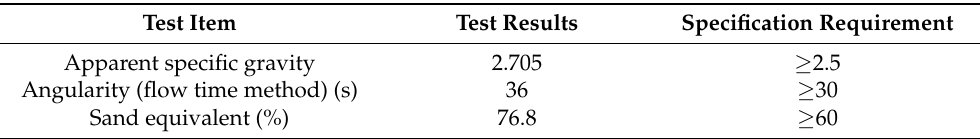
Table 2. Physical and technical properties of fine aggregates.